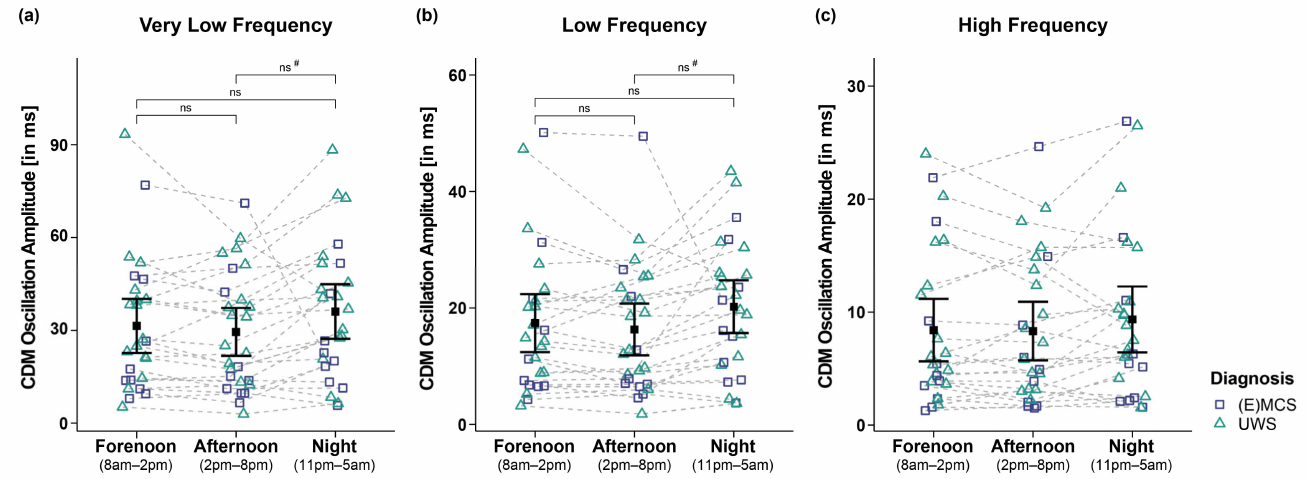
Figure 4. Very low (VLF), low (LF), and high frequency (HF) oscillation amplitude of the IBI signal computed by complex demodulation (CDM). Analyses of the ( a ) VLF and ( b ) LF band revealed significant main effects for time (i.e., forenoon, afternoon, night). However, post hoc comparisons between times of day did not yield significance anymore after correction for multiple comparisons. ( c ) Patients’ HF also did not differ between times and diagnoses. Error bars represent the mean and 95% confidence interval. # = significant before correction for multiple comparisons; ns = not signifi- cant. Abbreviations: (E)MCS = (emergence from) minimally conscious state; UWS = unresponsive wakefulness syndrome; ms = milliseconds.